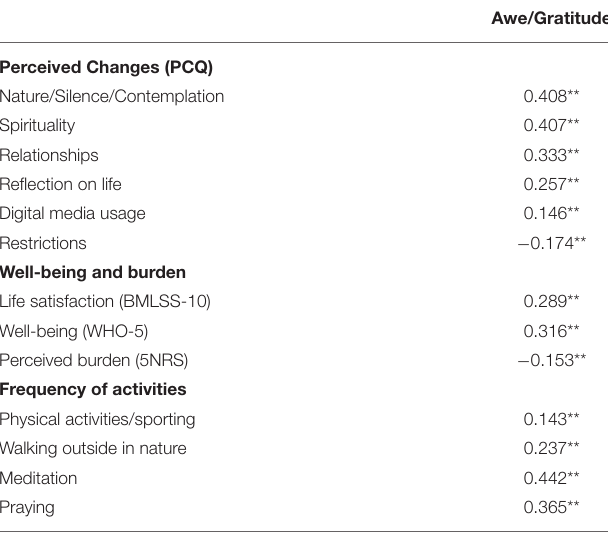
TABLE 4 | Correlations between Awe/Gratitude and other variables.